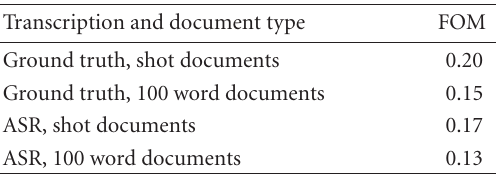
Table 4: FOM results: speech retrieval using human knowledge- based